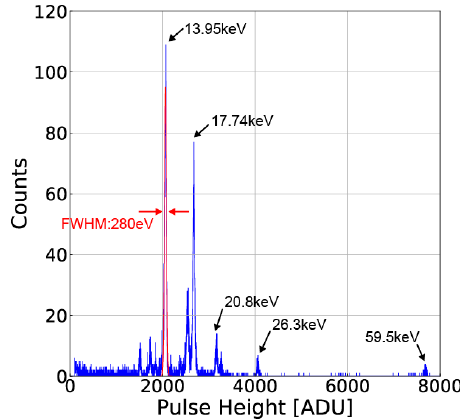
Figure 18. Measured X-ray spectra of 241 Am as single-pixel events using the SOIPIX-PDD. 1 ADU is 122 μ V/e − (2 V/14 bit).